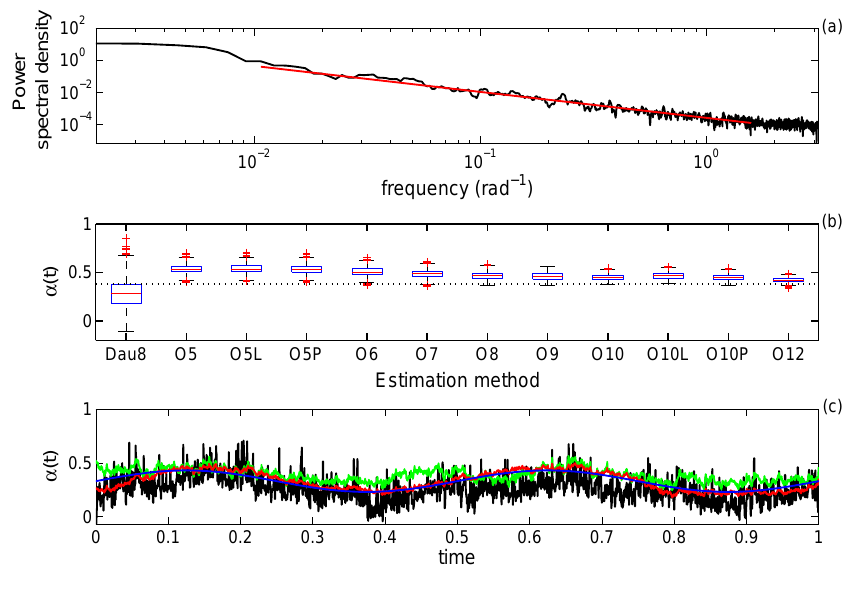
Fig. 10. Testing the oscillation-based method and a wavelet-based algorithm for estimating H¨older exponents. (a) Shows the spectrum of a fractional Brownian motion and a fitted slope, which is translated into a value for α in (b) (dotted line). The box and whisker plots in (b) show the median, upper and lower quartiles (boxes) values extending up to 1.5 times the interquartile range (whiskers) and outliers (red crosses) for the set of 4096 estimated values for α(t) as a function of the algorithm used. A wavelet method using a Daubechies wavelet with 8 vanishing moments is indicated by Dau8, while “O” indicates the oscillation method. The number following the “O” is the largest exponent used in the calculation for δ . Hence, “O8” means that the bins for δ ranged from 2 1 to 2 8 . Least-squares regression was used unless a suffix “L” (Lim Inf regression) or “P” (penalised least-squares regression) is included. See (FRACLAB, 2006) for more details. (c) Shows the sinusoidal function for α(t) used to generate a multifractional Brownian motion (blue line) and then estimated values for α(t) from that multifractional Brownian motion time series. The black line is the Dau8 algorithm, the green line is O5 and the red line is